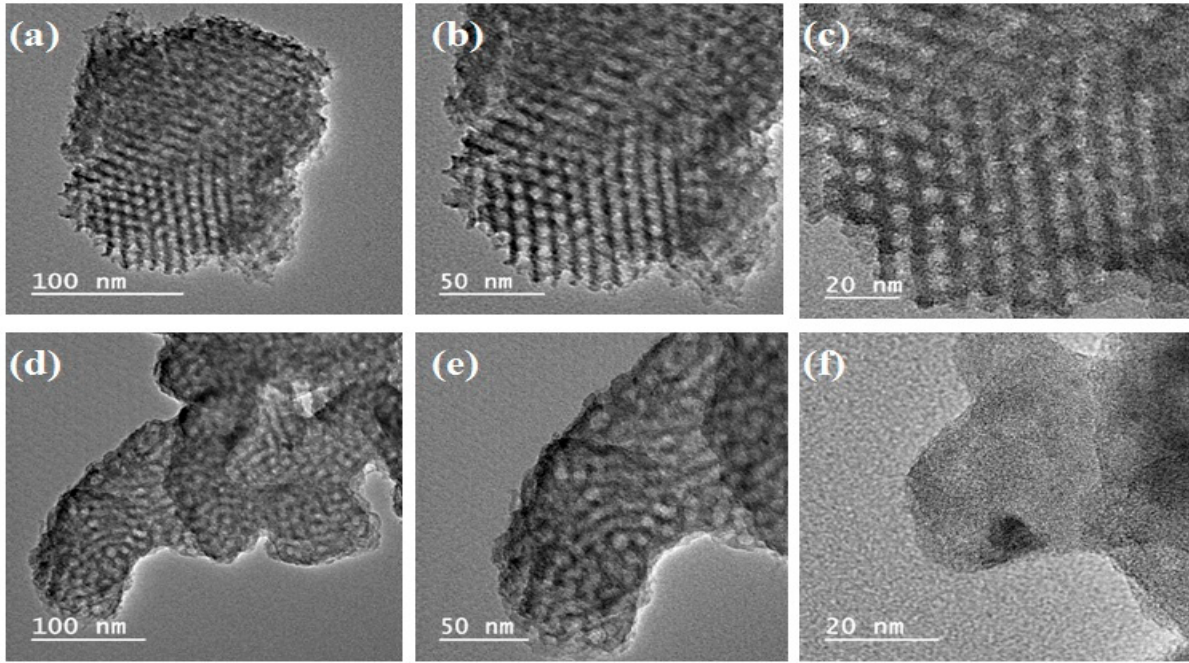
Figure 3. TEM images of COK12 ( a – c ) and Cu/COK12 ( d – f ).